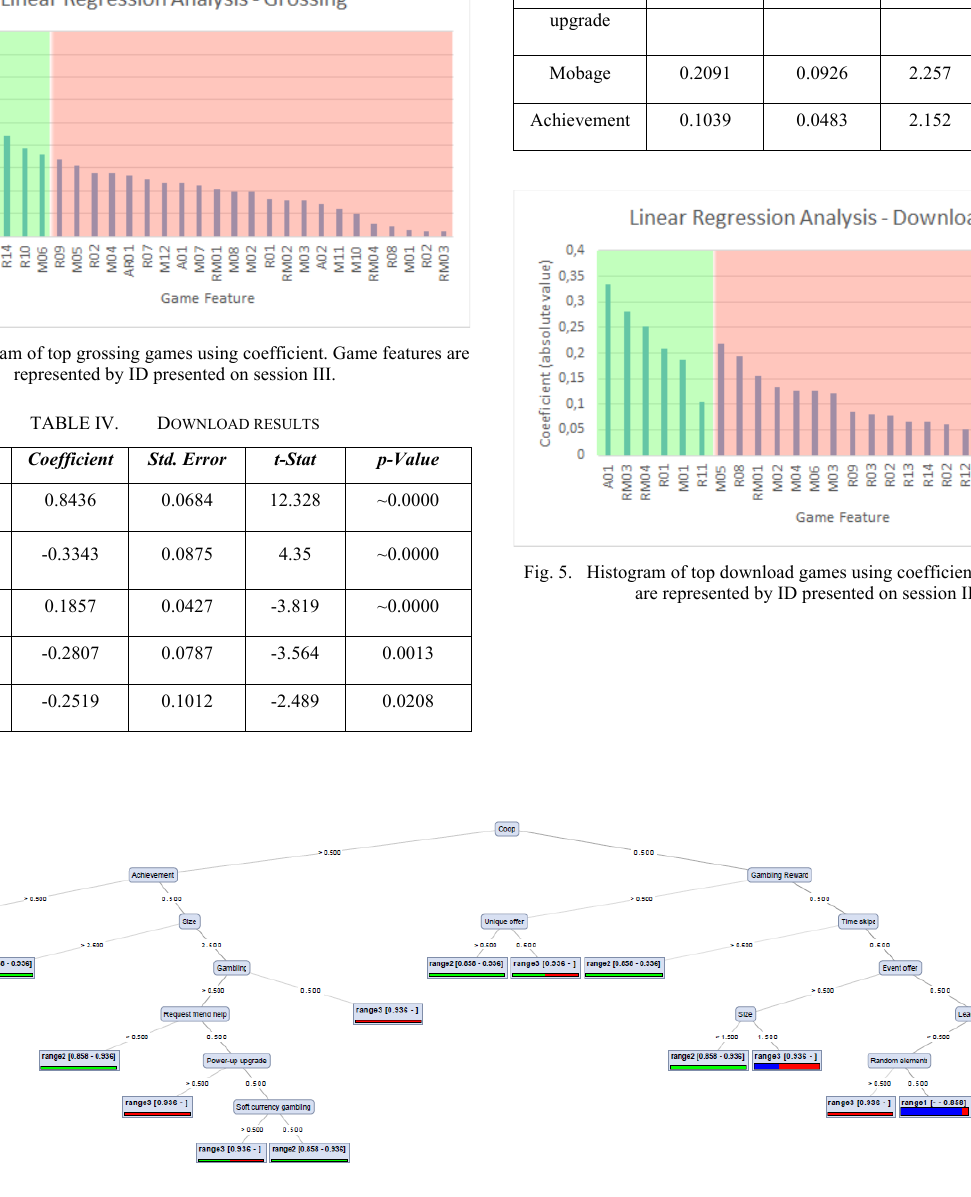
Fig. 6. Decision tree generated by Rapid Miner to Grossing